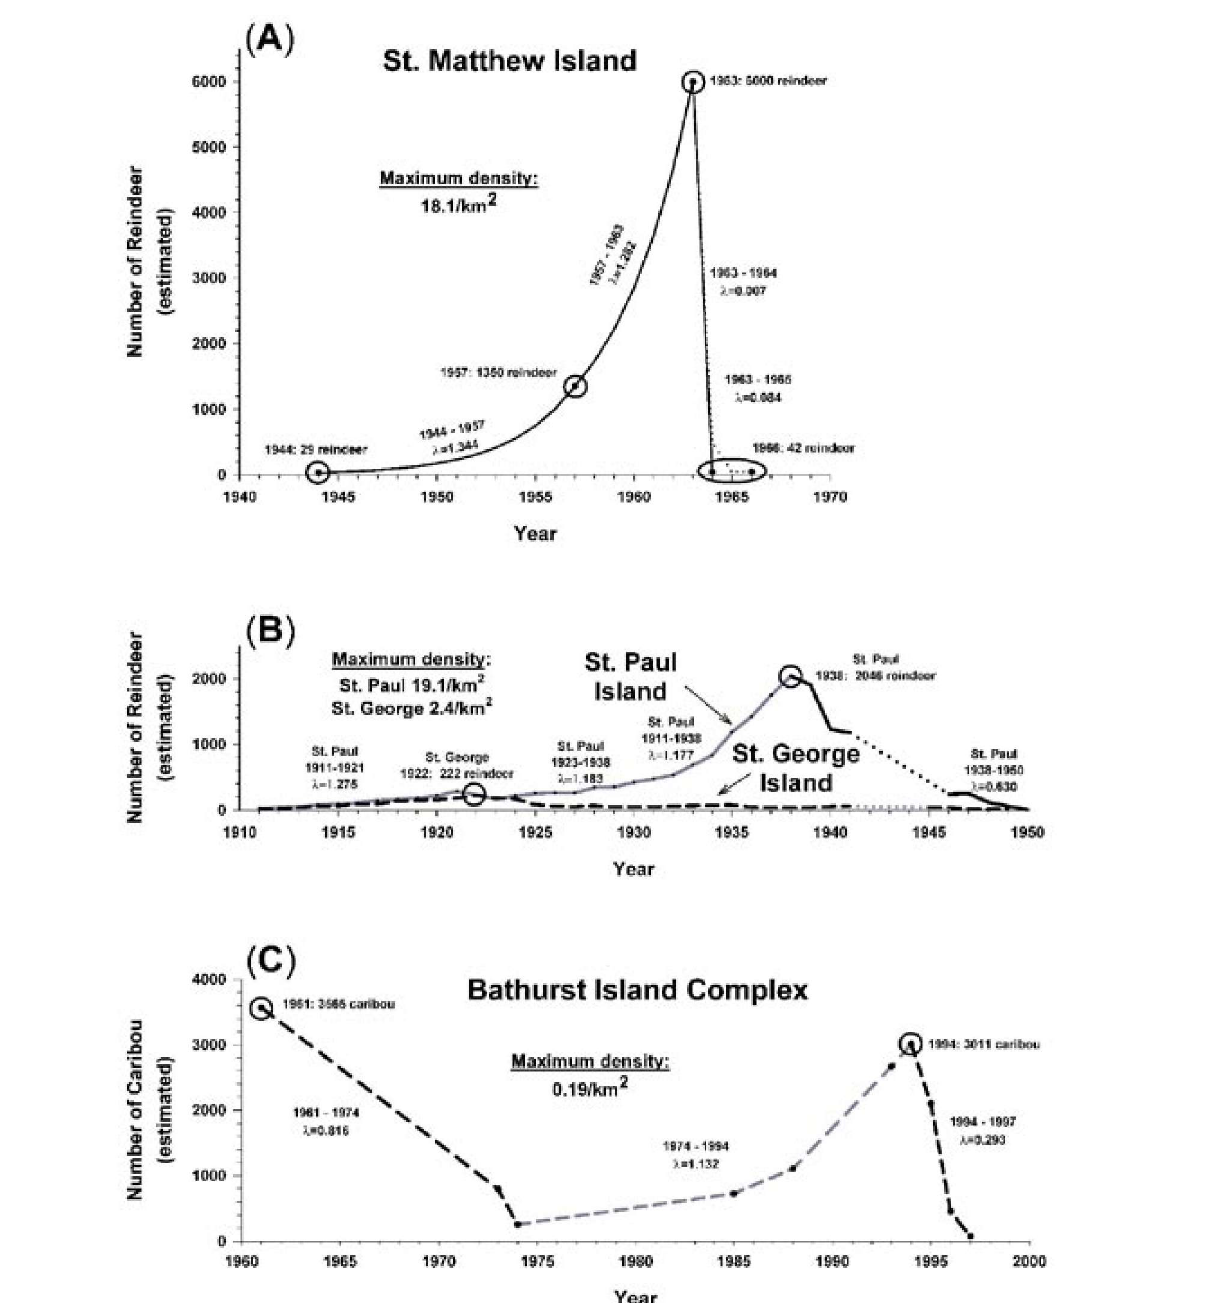
Fig. 1. (A) Assumed population growth of St. Matthew Island reindeer herd: a high-density introduced reindeer popula tion experiencing a single-year crash (after Klein, 1968: Fig. 2; data sources Klein, 1959, 1968); (B) Assumed population growth of St. Paul Island and St. George Island reindeer herds: St. Paul—a multi-year decline of a high-density introduced reindeer population with continued decline at low densities; and St. George—an intro duced reindeer population 'locked in' at relatively low densities (data from Scheffer, 1951: Table 1; Fig 1); and (C) Assumed population growth of Bathurst Island complex indigenous Peary caribou population: the fall, rise, and consecutive 3 years of single-year crashes of an extremely low-density Peary caribou population (data from Tener, 1963; Miller et al., 1977; Miller, 1987, 1989, 1995, 1998; Gunn & Dragon, 2002). 190 Rangifer, Special Issue No. 16,